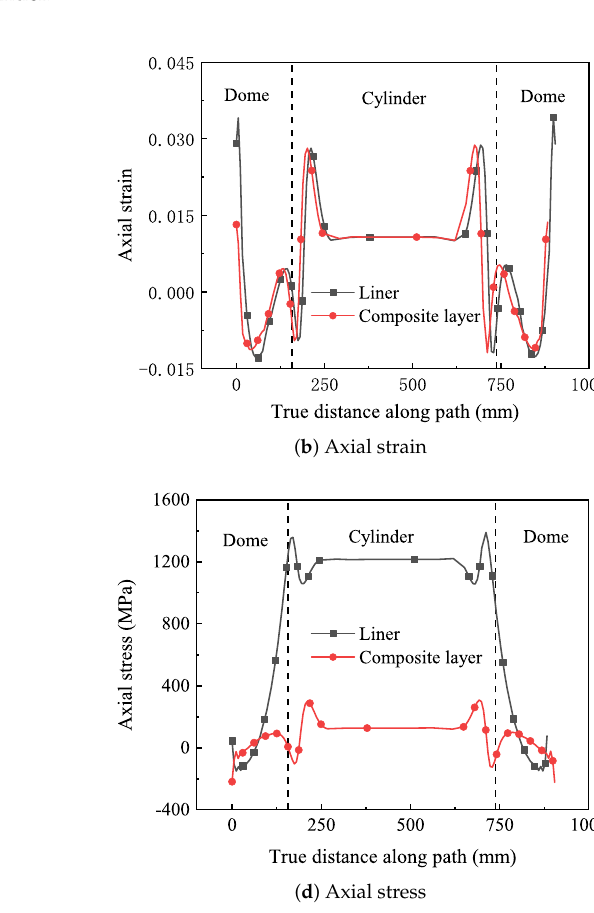
Figure 21. Simplified geometry model of type III pressure vessel, where A, B, C, and D refer to the vertices of the dome and cylinder.